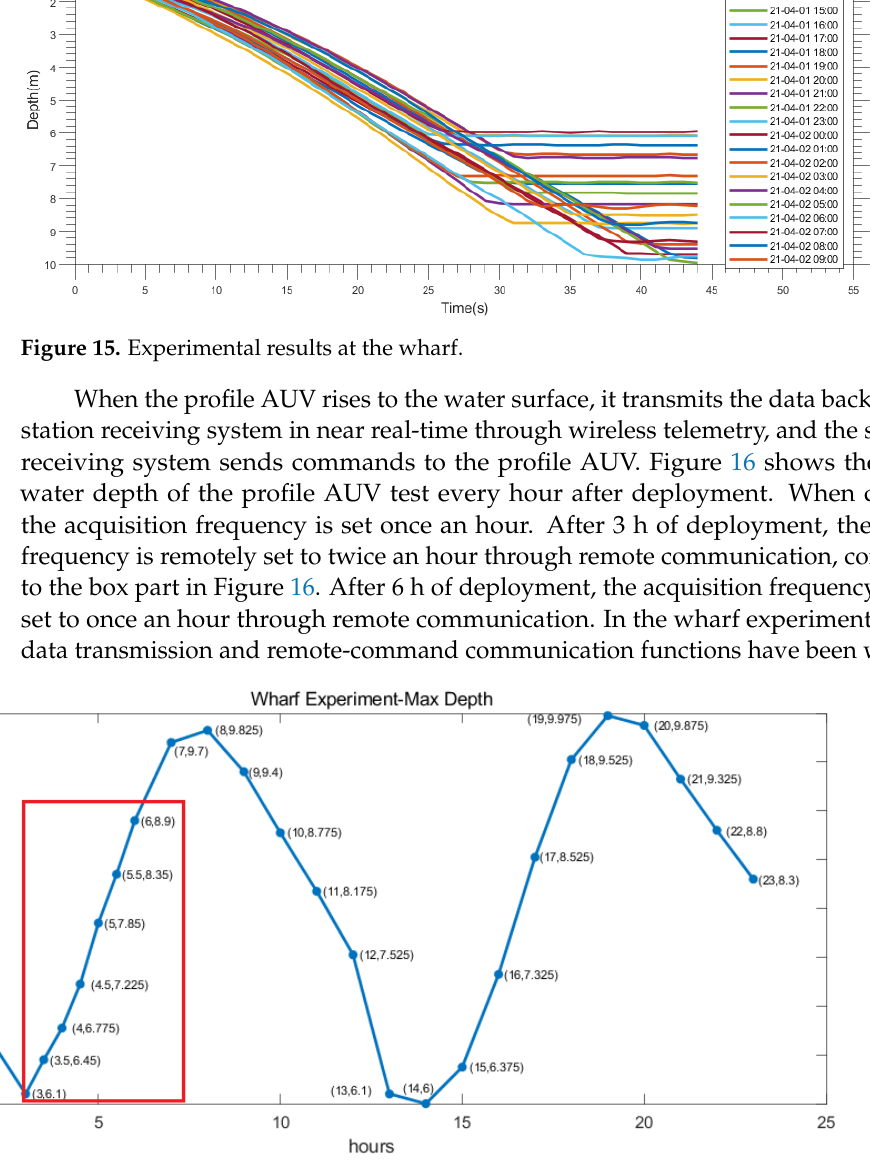
Figure 14. Experiment on the wharf .